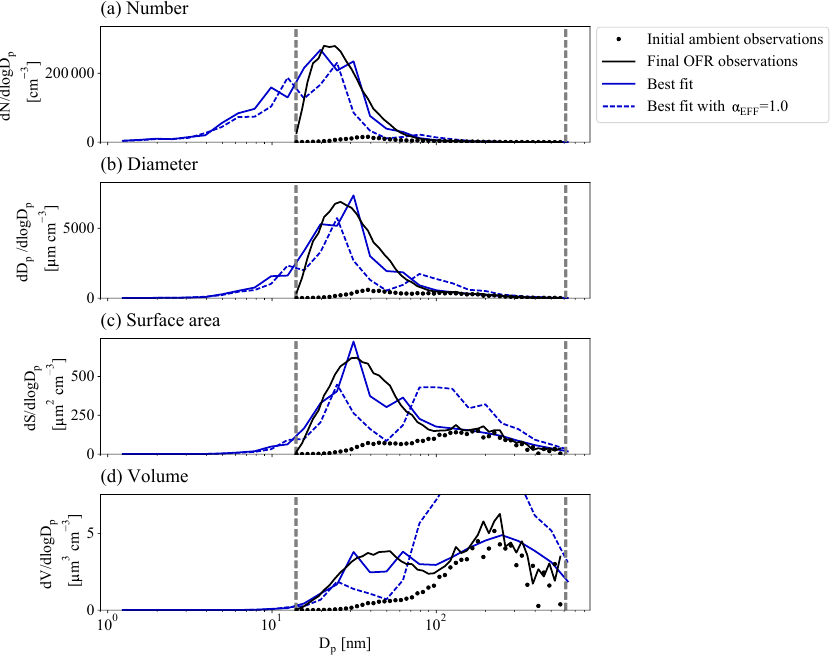
Figure 3. Example case of a 0.23 eq. day aging exposure from the BEACHON-RoMBAS campaign. The panels represent the moments used to calculate the normalized mean error (NME), with (a) as particle number, (b) as particle diameter (also referred to as aerosol length), (c) as particle surface area, and (d) as particle volume. The NME is calculated for each model run, using the final (OFR output) observed size distribution (black lines) compared to each model run’s final size distribution (colored lines). The solid blue lines are for the best-fit model case for this exposure, corresponding to 2 × k NUC1 , 5 × k OH , 0 . 5 × γ OH , k ELVOC , and α EFF = 0 . 01 (NME = 0 . 03). The dashed blue lines are for the same parameter values of the best-fit case, except that α EFF = 1 . 0 (NME = 0 . 3). The vertical grey dashed lines indicate the particle size range across which the integration for calculating each mean moment was computed. The initial observed ambient size distribution (dotted black lines) is also plotted for